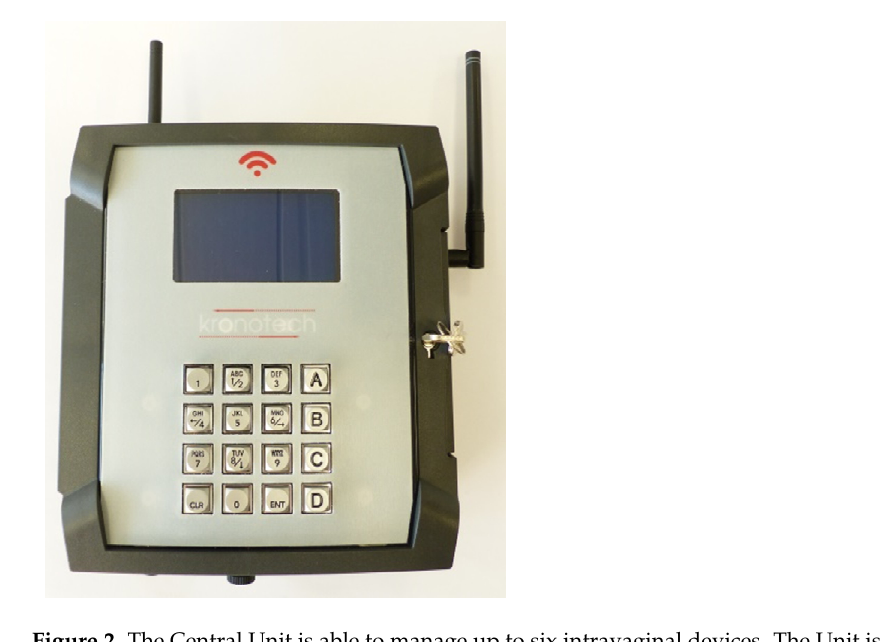
Figure 2. The Central Unit is able to manage up to six intravaginal devices. The Unit is composed of a screen, a keyboard and an internal housing which contains the circuit board, the slot for the cell phone Sim Card and a battery. To activate the probe, this is placed with the “magnet side” toward the red symbol .